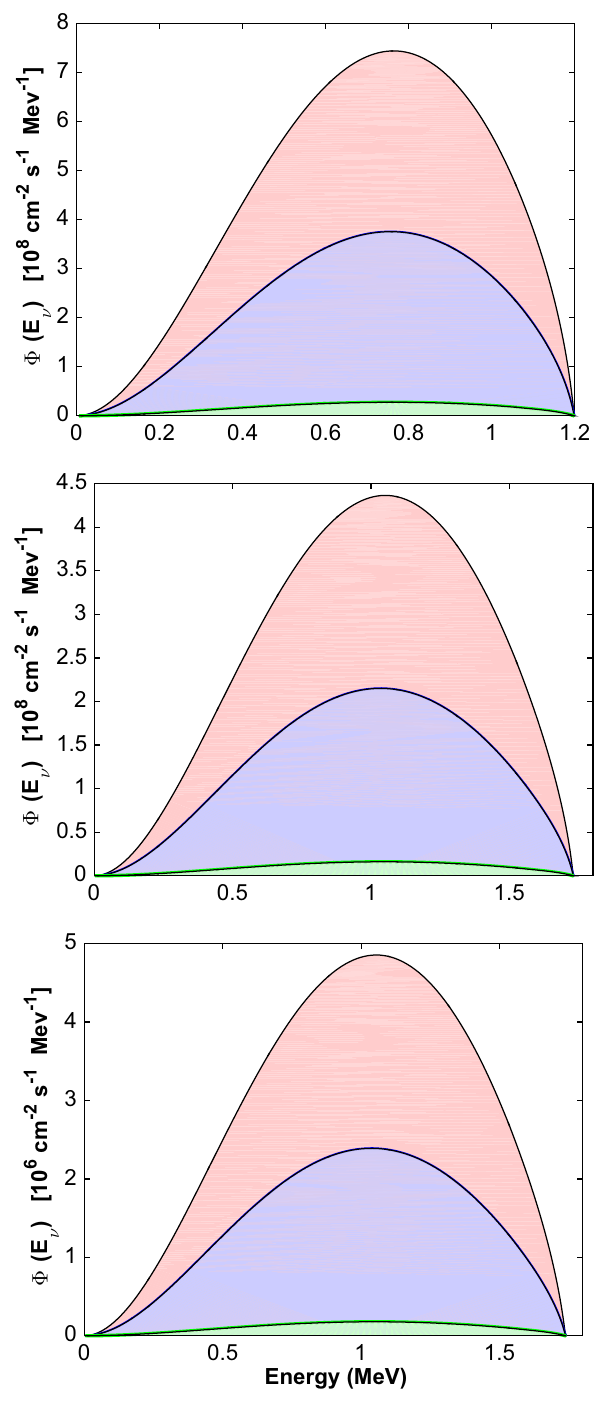
Fig. 9 The solar neutrino spectra for CNO neutrinos: Neutrino spectra of the cno nuclear reactions. N 13 ν (top), O 15 ν (middle) and F 17 ν (bottom). The colour scheme is the same as used in Fig. 5 sensitive to the local values (radius r ) of the temperature, molecular weight, density, neutron and electronic densities. propagate in the Sun’s interior, the neutrino flavours